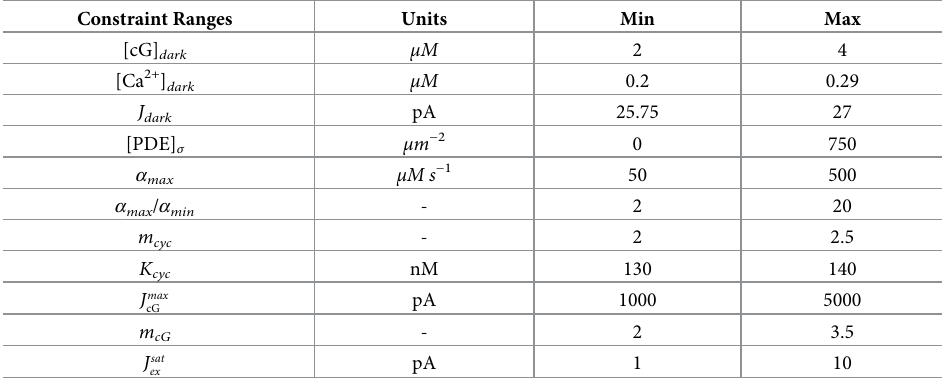
Table 7. Strict constraints imposed on many parameters that influence the dark current and the values derived from those parameters. The range for dark current was centered about the experimental flash response of [45], also shown in Fig